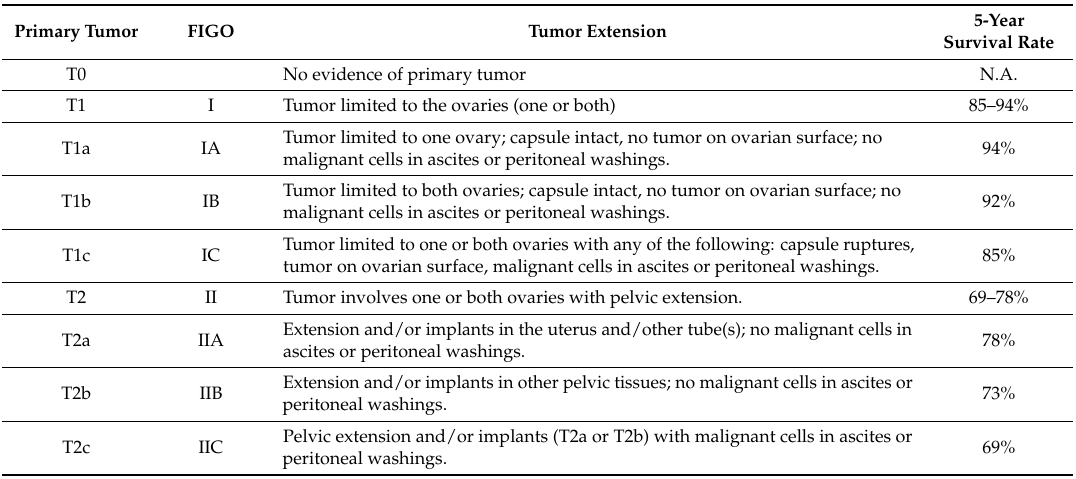
Table 2. Tumor-node-metastasis (TNM) and International Federation of Gynecology and Obstetrics (FIGO) classifications. The 5-year survival for the various stages is